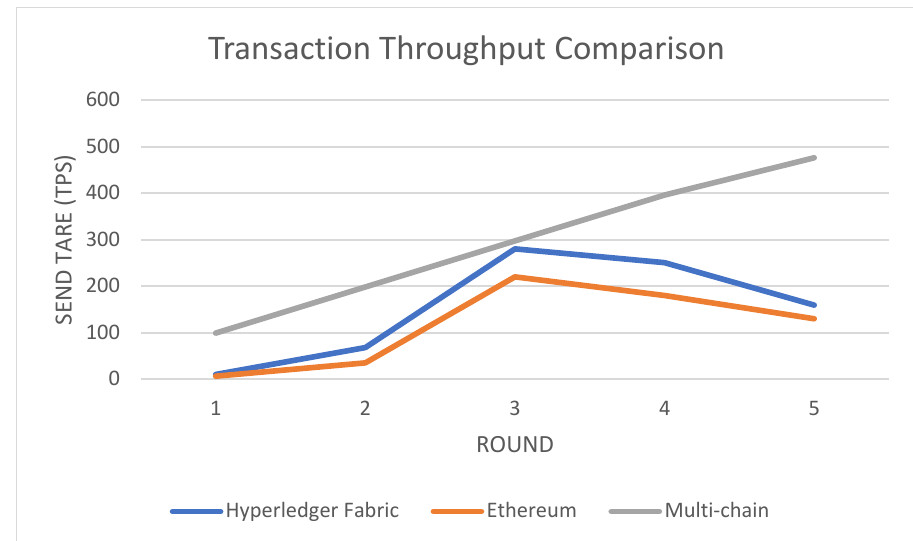
Figure 31. Comparison of three types of network transaction throughput performance.